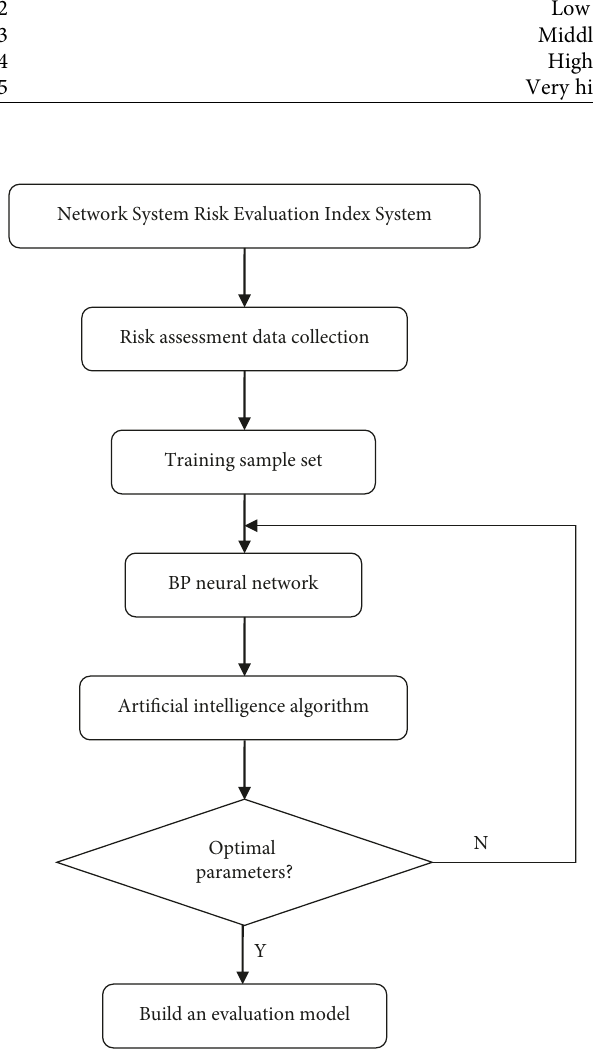
Figure 2: Risk assessment training process of wireless mobile power communication